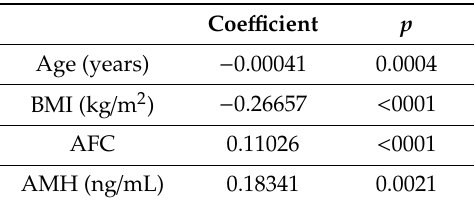
Table 2. Correlation among the OSI, clinical (age, BMI), endocrine (AMH) and US (AFC) variables related to ovarian responsiveness (multivariable linear regression analysis). Age and BMI turned out to be negatively related with the OSI, whereas the AMH and AFC were positively related. All the correlations were statistically